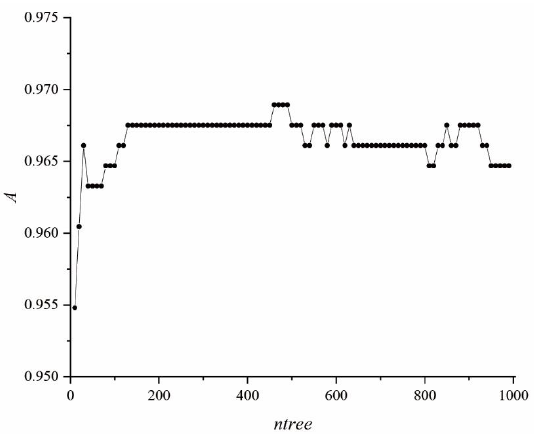
Figure 3. Overall accuracy (A) of hard classification variations as a function of the number of trees ( ntree ).